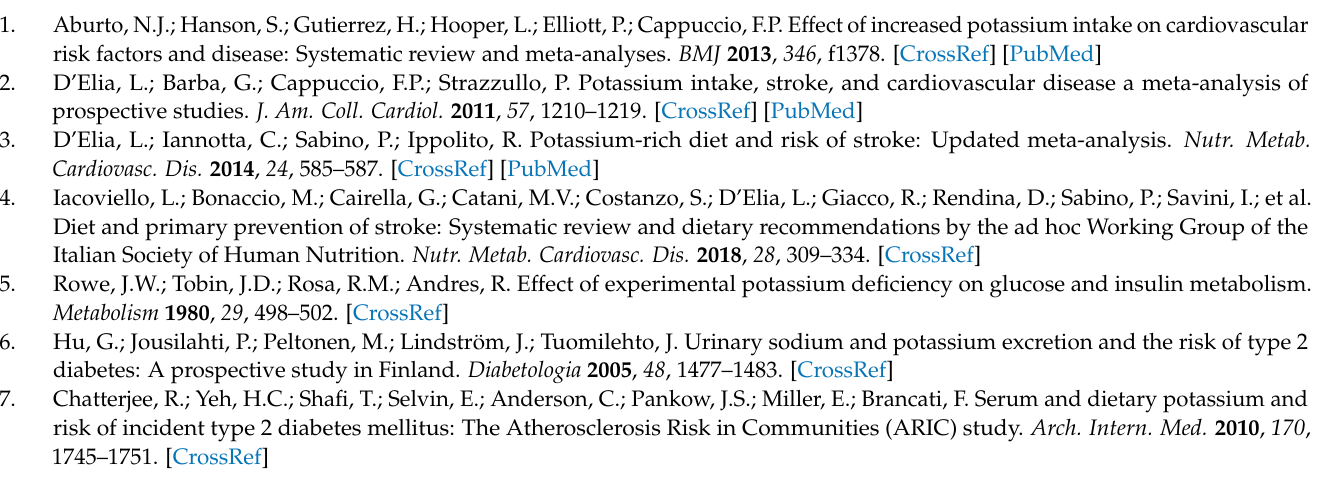
PRISMA Checklist; Table S2: Newcastle–Ottawa Quality Assessment Scale for cohort studies included in the meta-analysis; Table S3: Meta-regression analysis of the effect of dietary potassium intake on diabetes